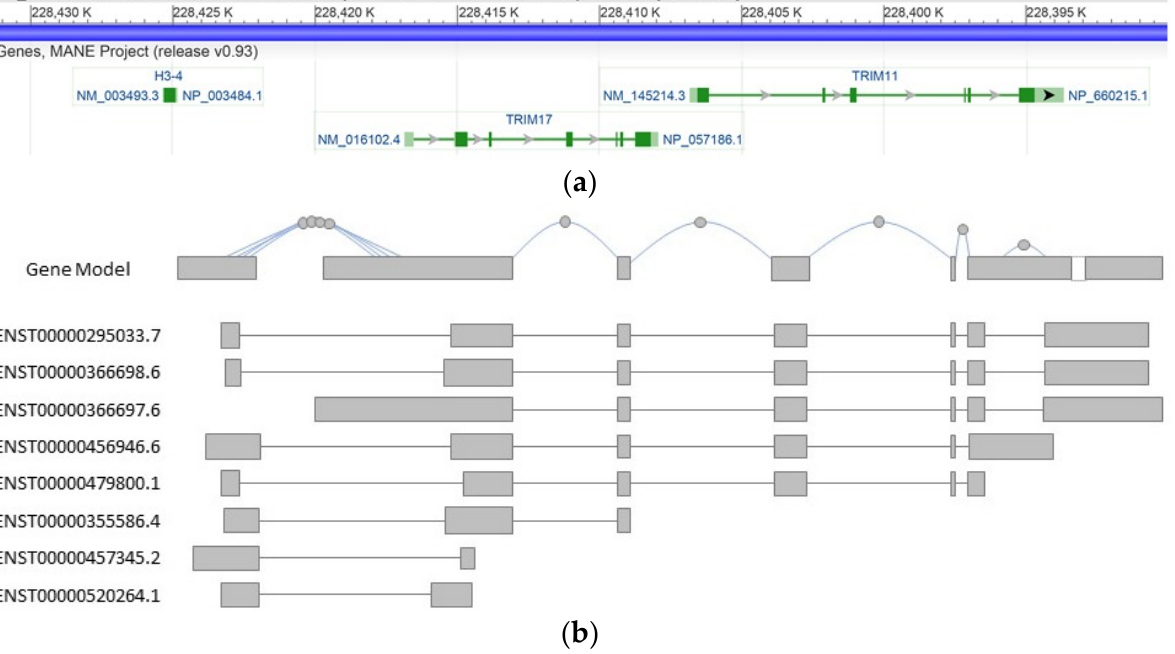
Figure 2. ( a ) Screenshot from NCBI’s Genome Data Viewer. The data track MANE Project (release v0.93) shows TRIM17 and TRIM11 genes’ localization and transcripts (NCBI’s Refseq names NM_016102.4 and NM_145214.3, respectively) on GRCh38.p13 primary assembly; ( b ) gene model (ENSG00000162931.11) and TRIM17 mRNA isoforms (from gtexportal.org, 21 February 2021, Source: HGNC Symbol; Acc: HGNC:13430).